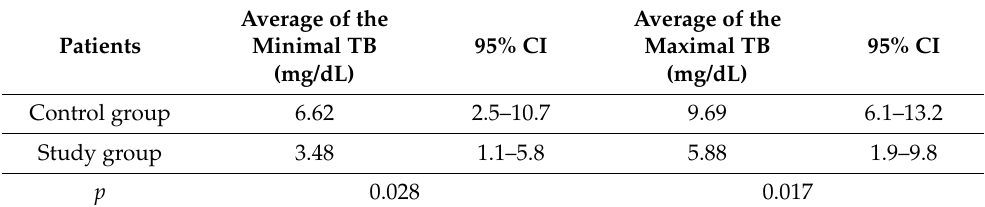
Table 2. Variability of the minimal and maximal bilirubin levels between groups.